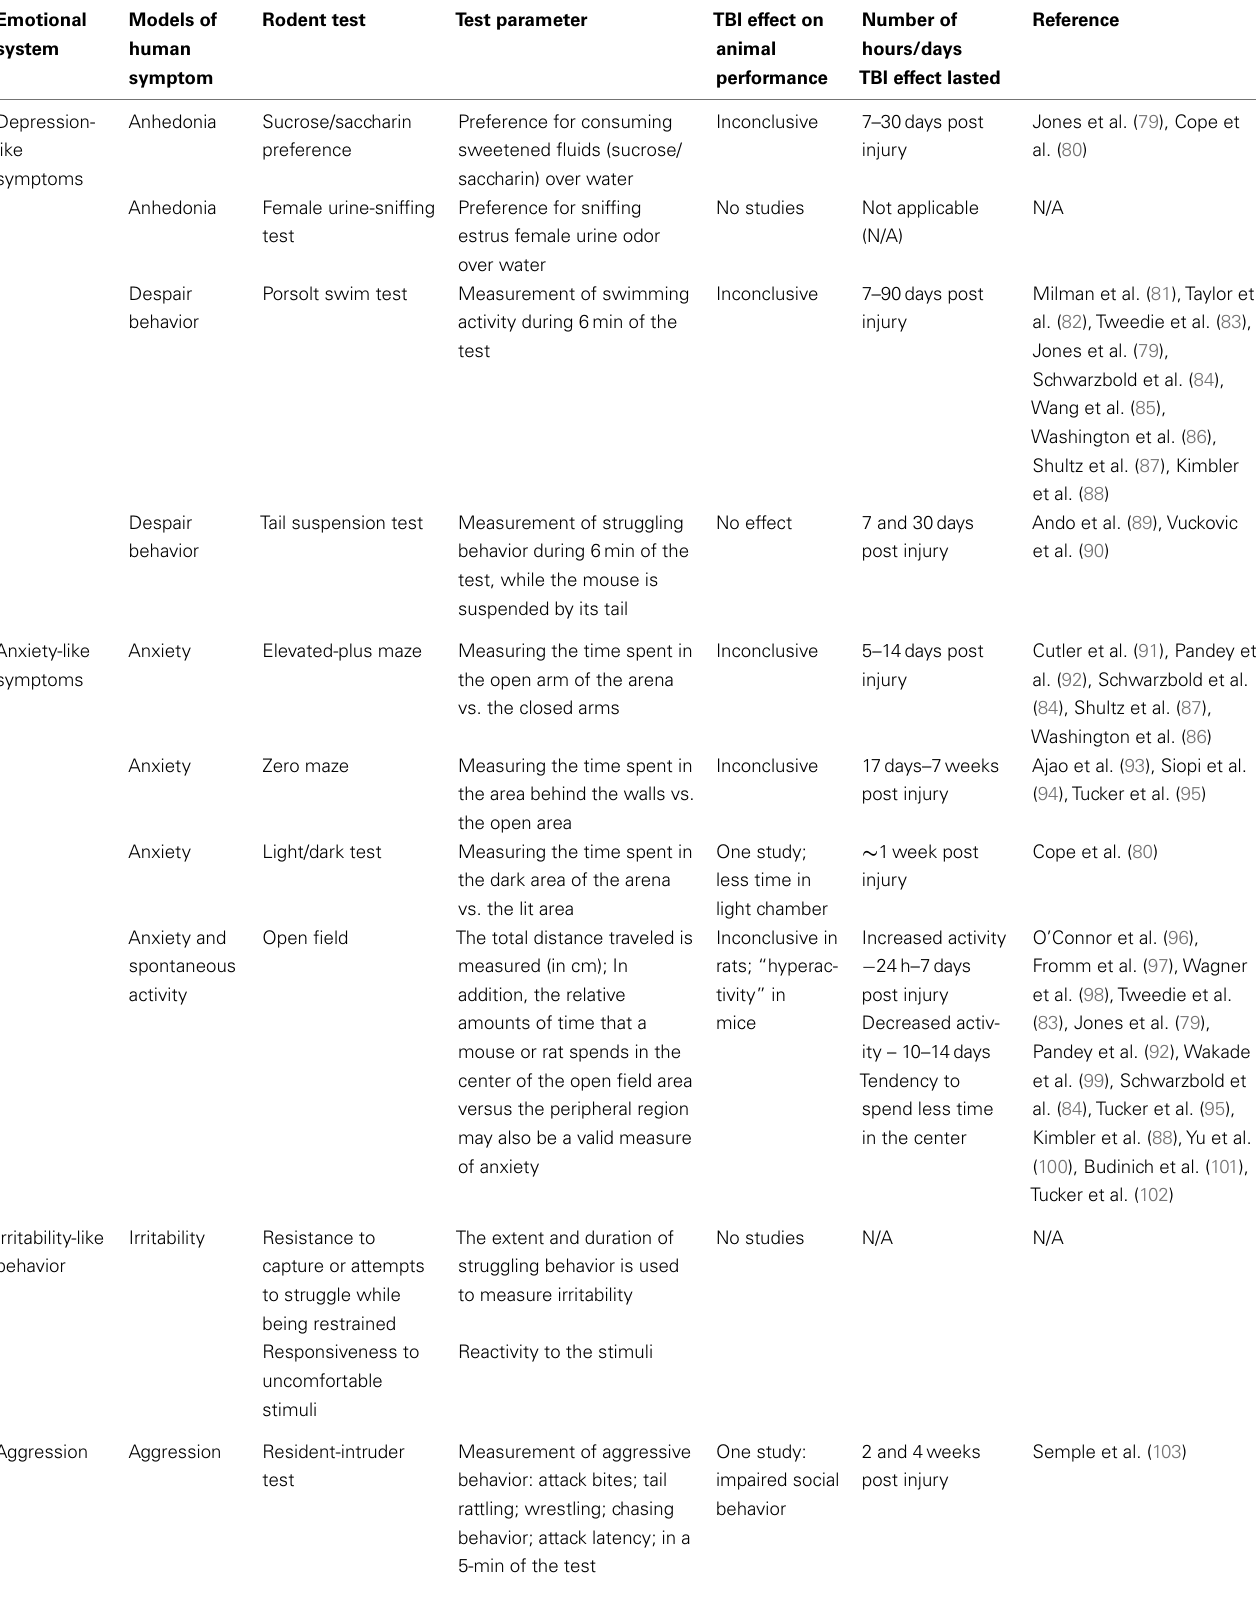
Table 2 | Summary of human emotional systems and animal tests related to post-TBI symptoms in